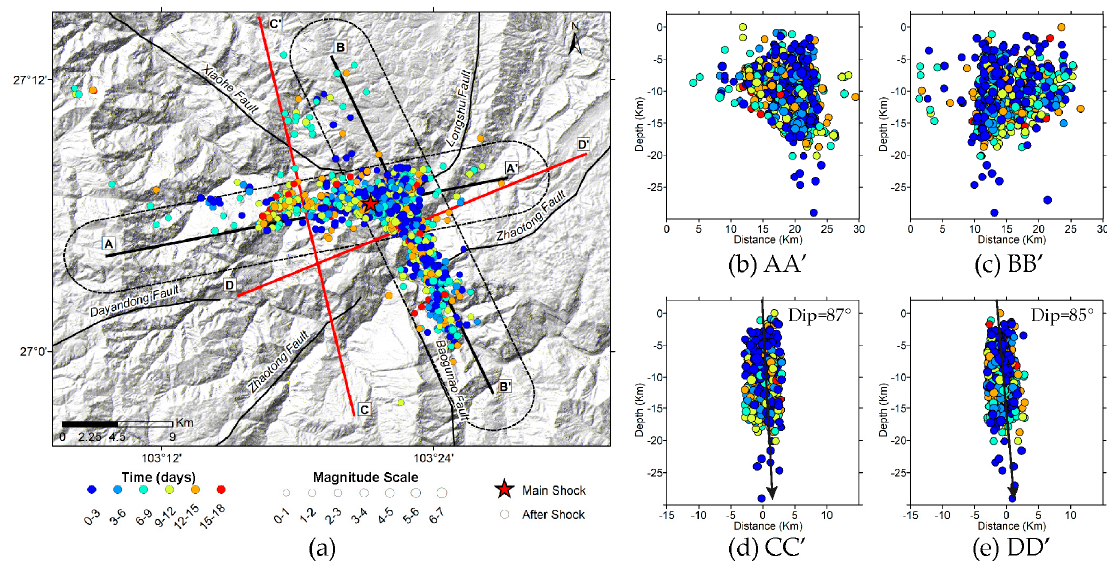
Figure 3. ( a ) Distribution of the relocated aftershocks. ( b ) Focal depth distribution of the aftershock sequencesalongtheAA’profile. ( c )–( e )Sameas( b ),